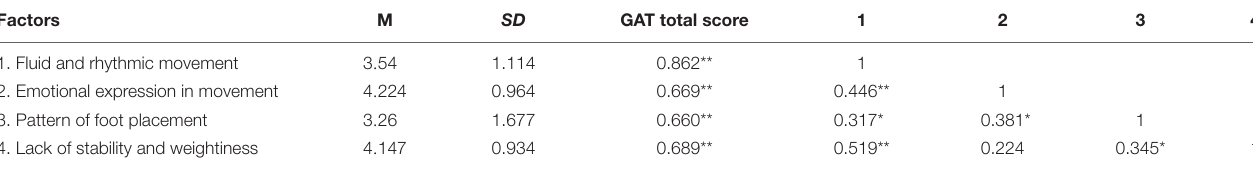
TABLE 8 | Descriptive statistics and correlations for Grounding Assessment Tool (GAT)